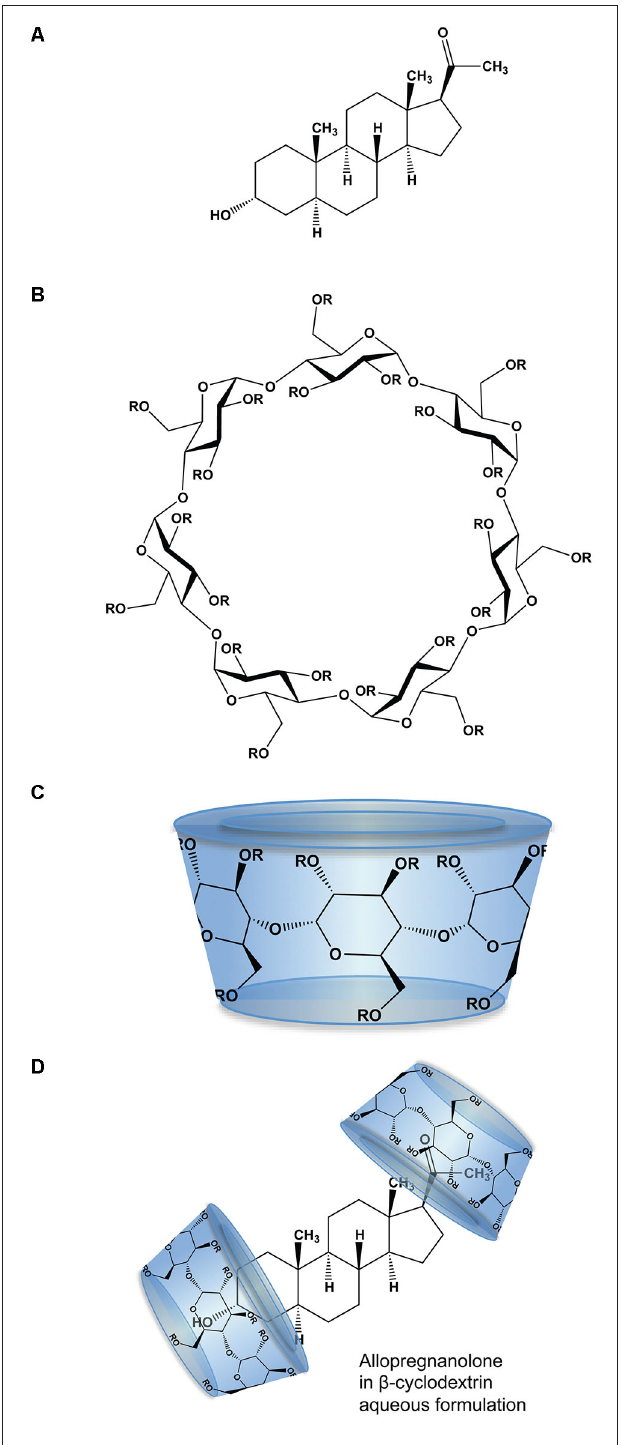
FIGURE 1 | Molecular structure and formulation of allopregnanolone . (A) Chemical structure of allopregnanolone; molecular weight 318.49 g/mol. (B) Chemical structure of β -cyclodextrin derivatives, where R is hydrogen or 2-hydroxypropyl (CH 2 CHOHCH 3 ) for HBCD or sulfobutylether ((CH 2 ) 4 SO 3 Na) for SBECD. HBCD has an average molecular weight ∼ 1460 g/mol, with 0.7–3.15 average degrees of substitution for hydrogen. SBECD molecular weight ∼ 2163 g/mol with average degrees of substitution estimated ( Continued